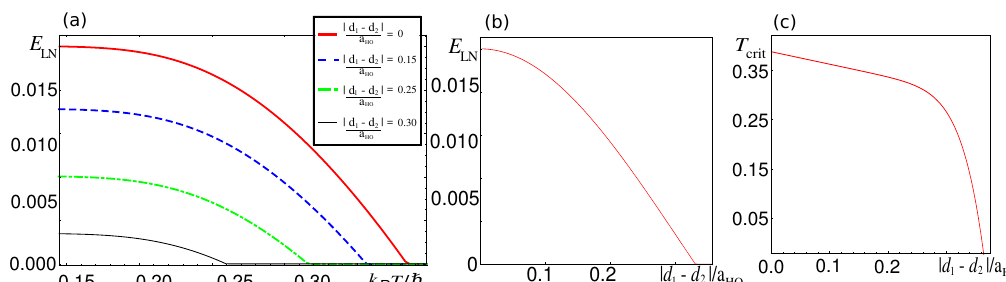
Figure 4: Distance dependence of the entanglement between the two kinds of impuri- ties. In (a) we study entanglement as a function of T for various distances between the trap of each kind of impurity. As expected the entanglement is reduced as the distance is increased. This is shown in figure (b). For each distance, at certain T the entanglement vanishes. The dependence of this critical temperature as a function of distance is shown in (c). In all of the graphs, we are considering impurities of potas- sium K in a bath of particles of Rubidium Rb. The parameters used in these plots are: Ω = 600 π Hz , Ω = 450 π Hz , η = 0.325, η = 0.295, n = 90 ( µ m ) − 1 , T = 4.35 nK 1 2 1 2 0 = 2.36 · 10 − 38 J · m . and g B